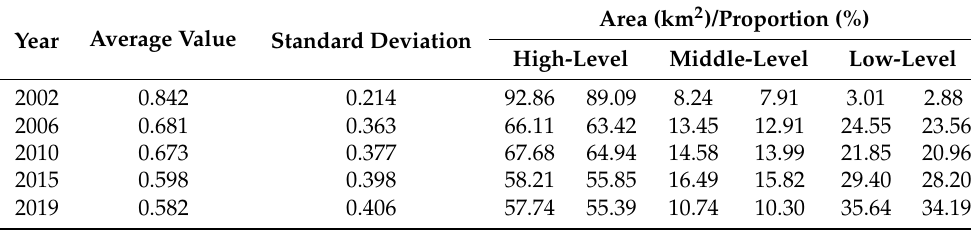
Table 4. Habitat quality index of the Lin-Gang core area